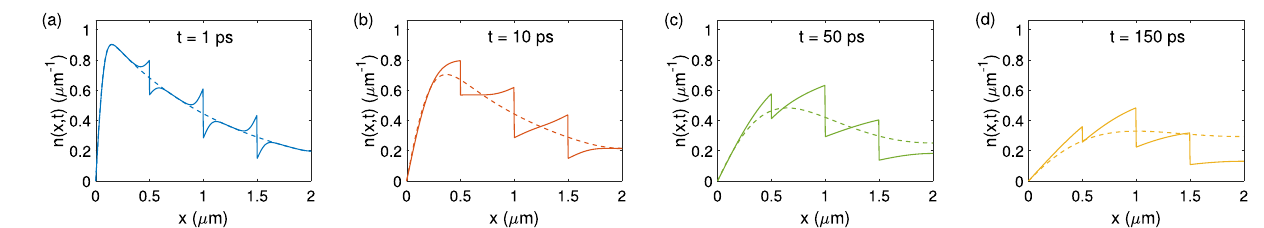
Figure 3. The distribution of electron concentration n ( x , t ) in the sublayer AL at different values of the time delay t , predicted by the SDM (solid) and the GDM (dashed) with a doping profile as shown in Fig. 2 and a 2 diffusion coefficient D = 20 cm /s.